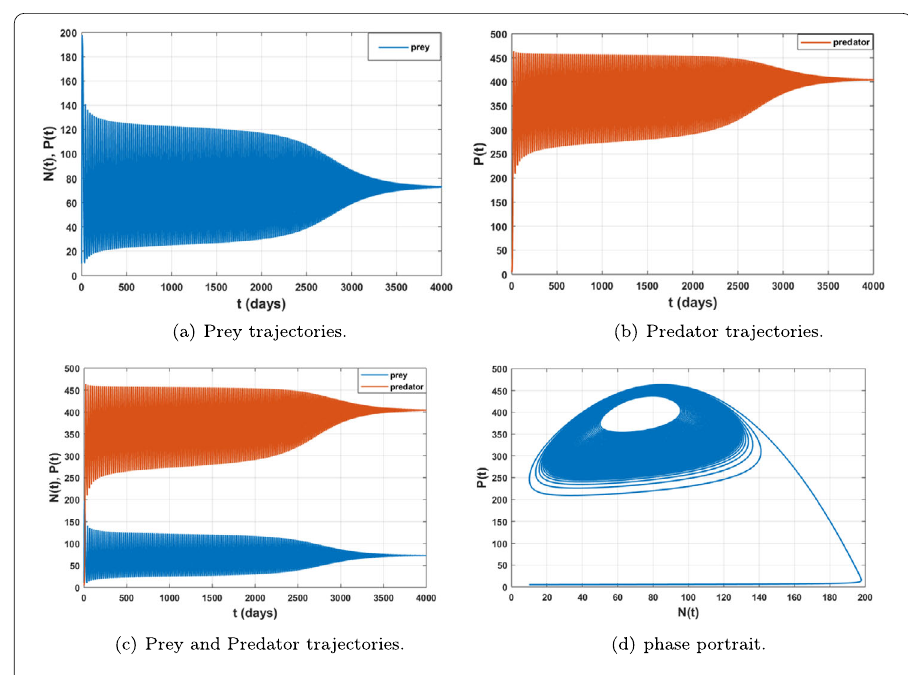
Figure 7 Local asymptotic stability of the coexisting equilibrium E – 3 of system (2.3) corresponding to δ 1 = 0.044